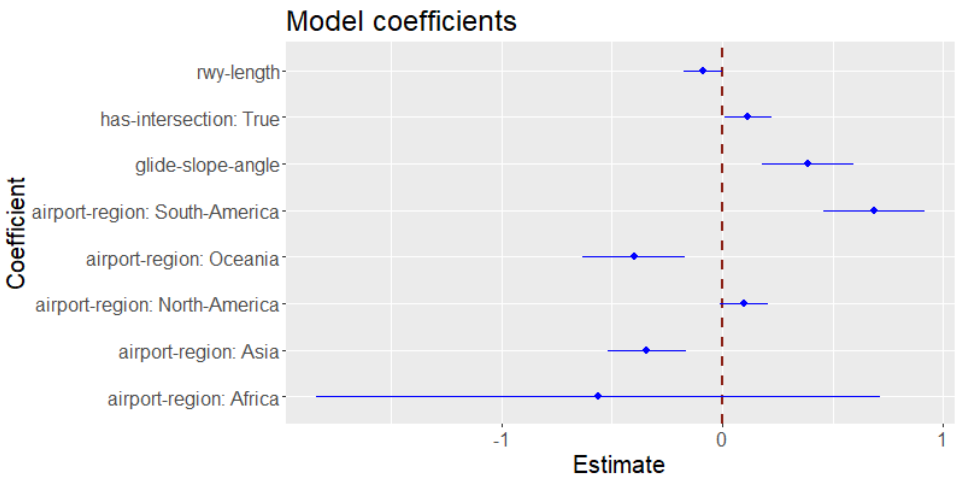
Figure 2. Illustration of the model coefficients and its confidence intervals obtained from the quasi- binomial